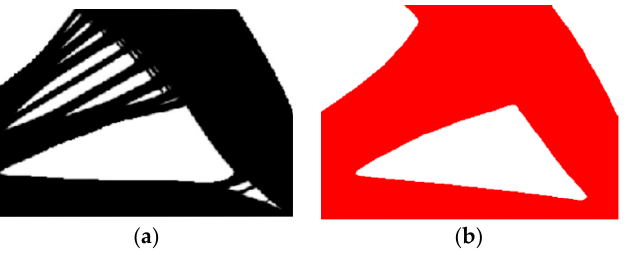
Figure 3. The appearance of thin and slender parts of structural topology in the case of a fine mesh has to be controlled by filtering techniques: ( a ) example of a fine mesh without filtering; ( b ) example of a fine mesh with filtering.